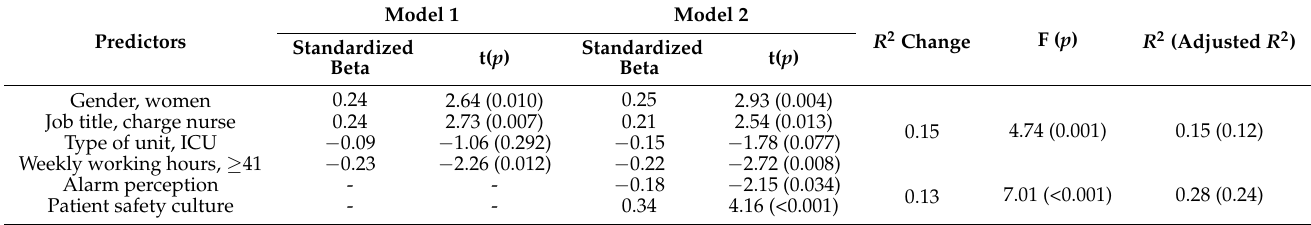
Table 5. Hierarchical linear regression analysis for nurses’ alarm management practice (N =